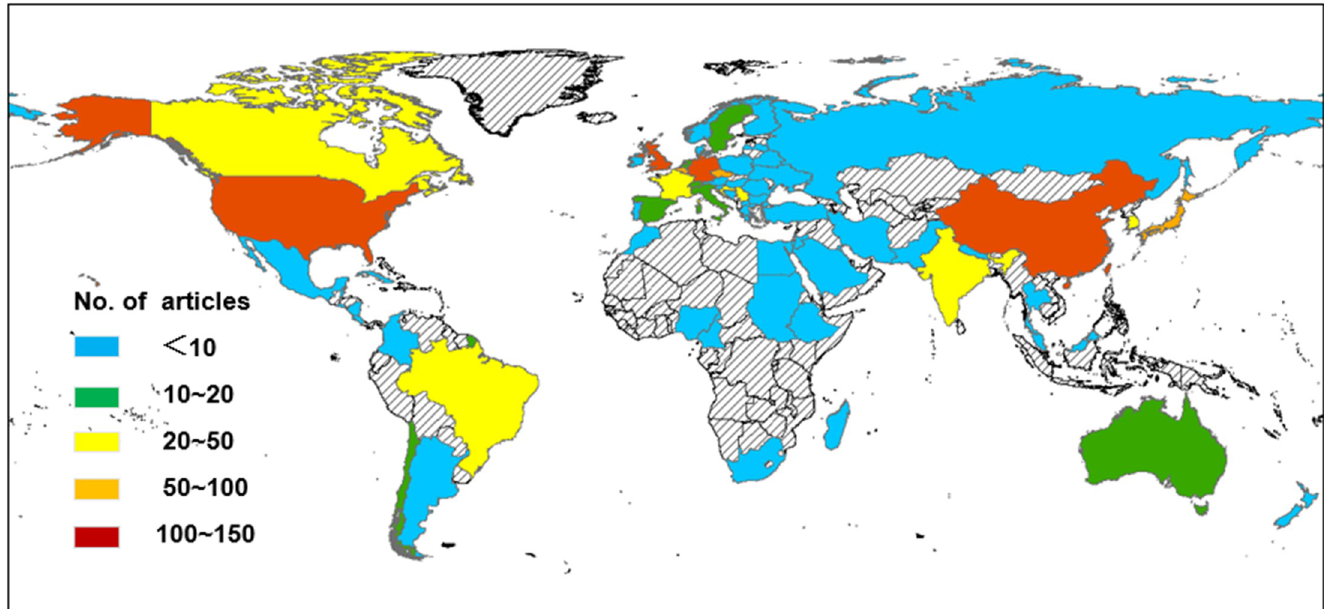
Fig 3. Geographical distribution of AA-related research articles,